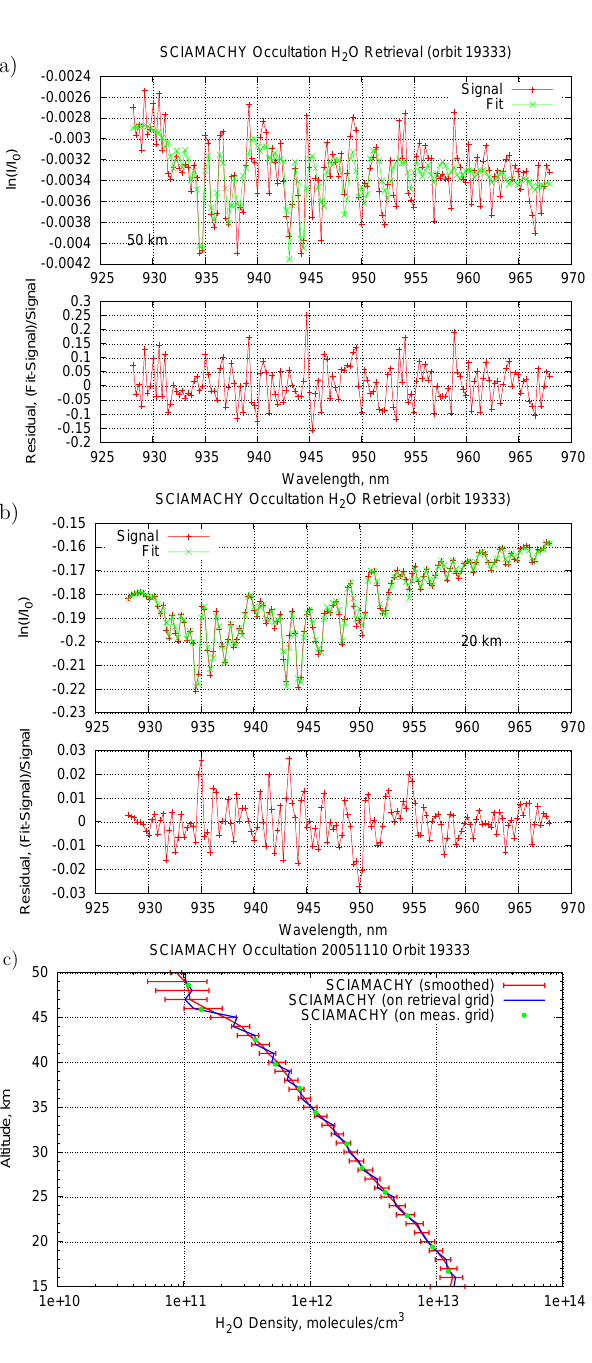
Fig. 5. Example fit results for a SCIAMACHY occultation mea- surement on 10 November 2005. (a) Measured signal and fit (top) and corresponding residual (bottom) for 50km tangent altitude. (b) Same for 20km tangent altitude. (c) Resulting water vapour profile from SCIAMACHY data (smoothed, un-smoothed, and in- terpolated to measurement altitude grid).